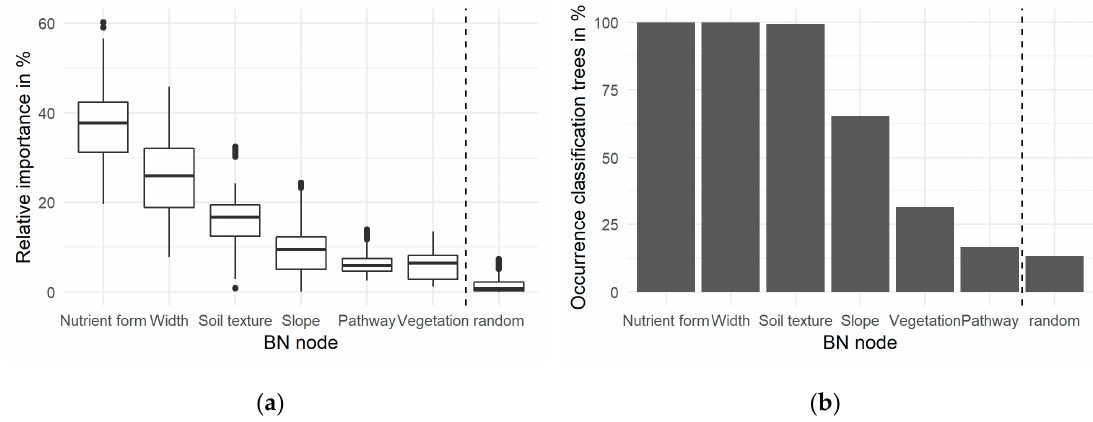
Figure 5. Relative importance ( a ) and occurrence of BN nodes ( b ) in the classification trees compared to a random binary variable. Note the changed order of (RBZ) vegetation and (flow) pathway.